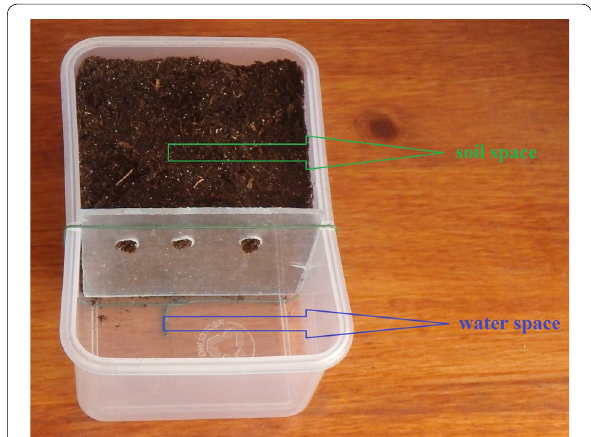
Fig. 1 Experimental device used to search for xenobiotics substances in plants (©Frédéric Darriet)